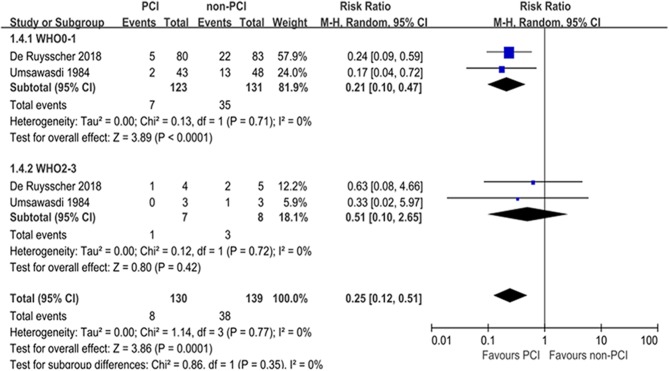
Subgroup analyses for BM according to performance status.